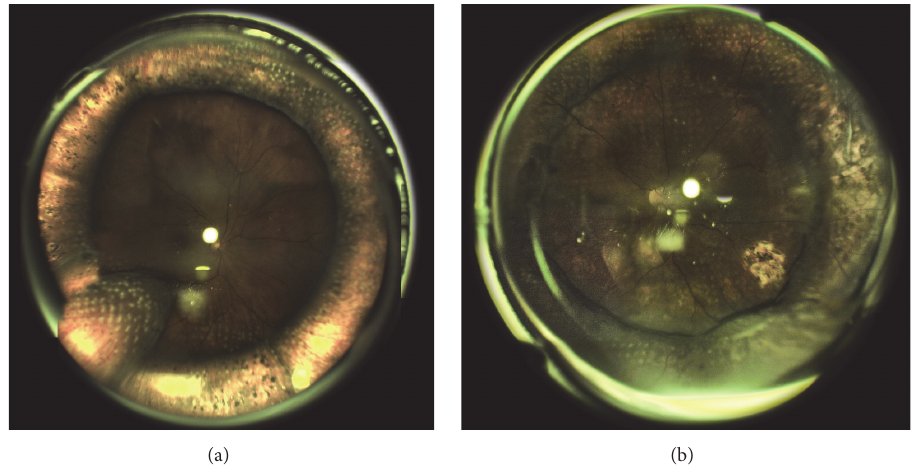
Figure 1: (a) Fundus image of the patient with a circular scleral buckle (CSB) and a meridional scleral buckle for multiple retinal tears, after two LRP sessions, with the surgical goal fully achieved. (b) Fundus image of the patient with a CSB and silicone oil tamponade of the vitreous cavity, after a single “pattern LRP” session, with the surgical goal fully achieved (LRP at a single tear was performed